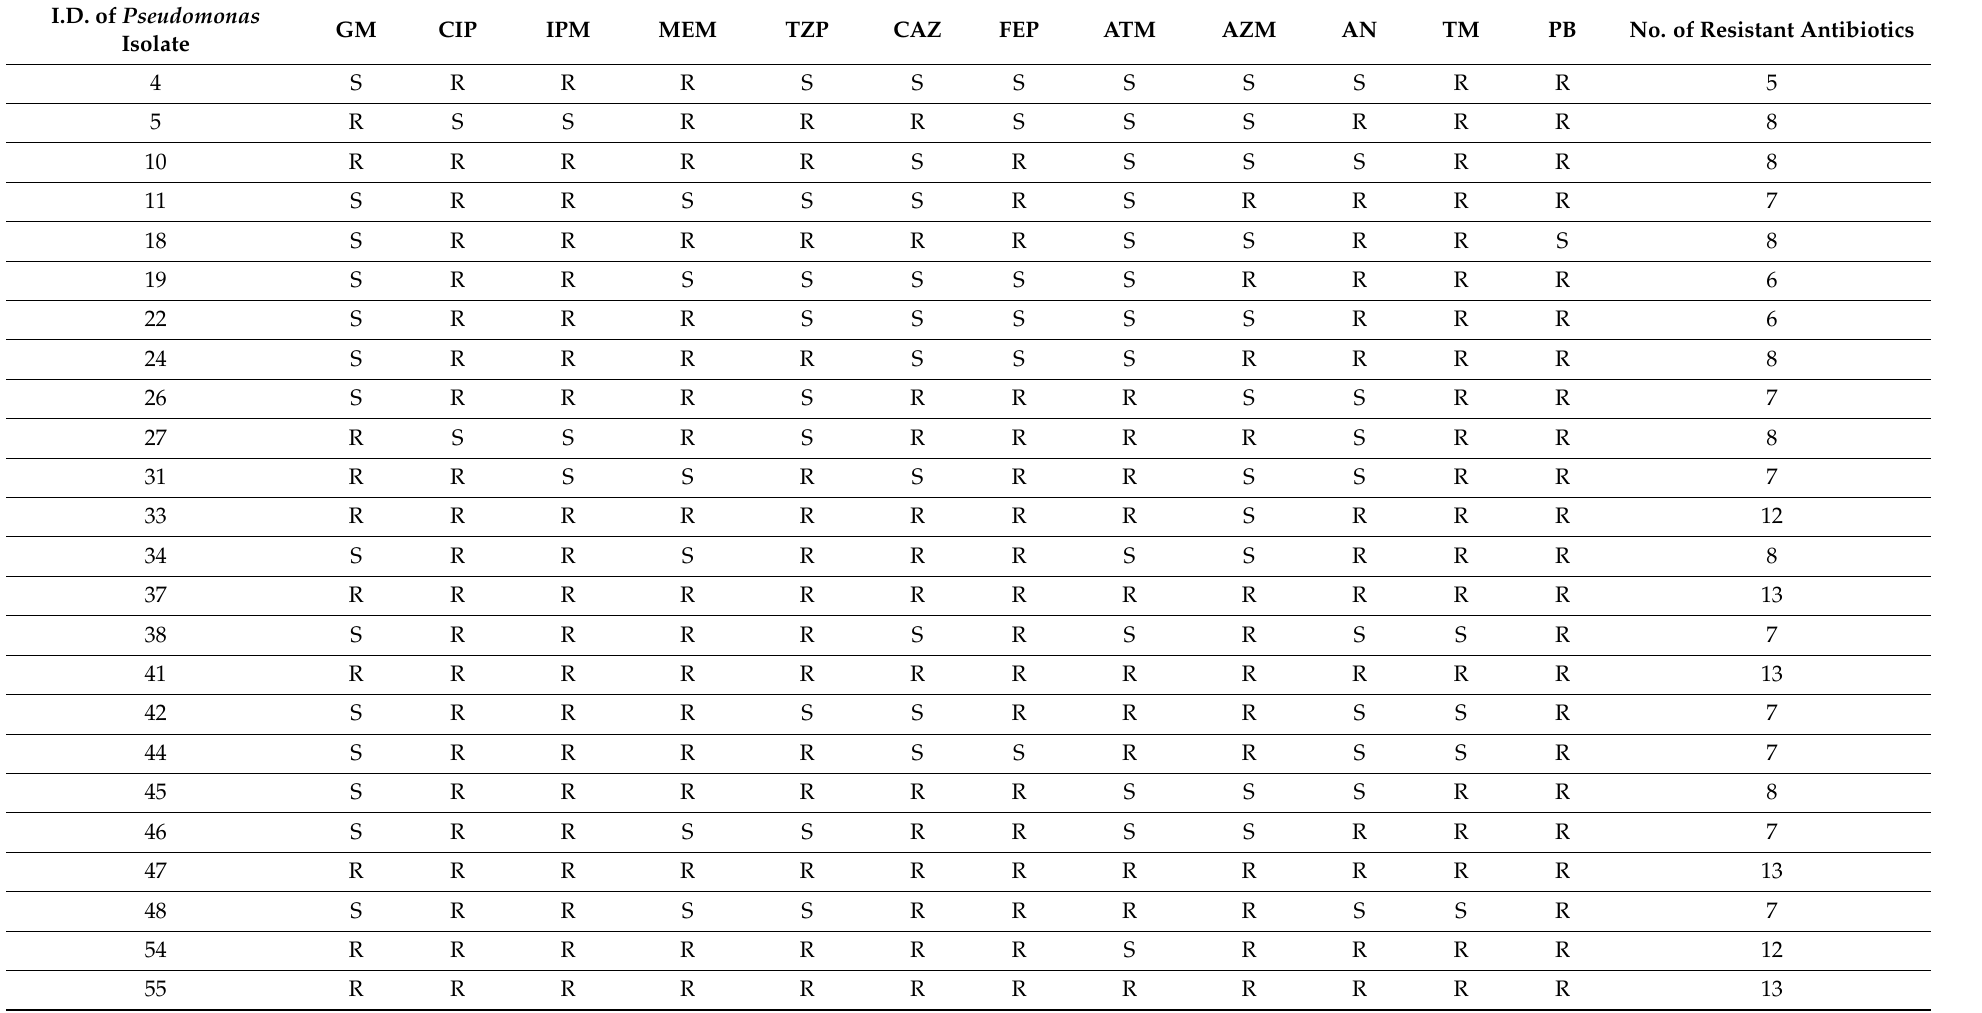
Table 6. Results of antibiotic susceptibility testing of Pseudomonas aeruginosa isolates from perianal abscesses ( n =